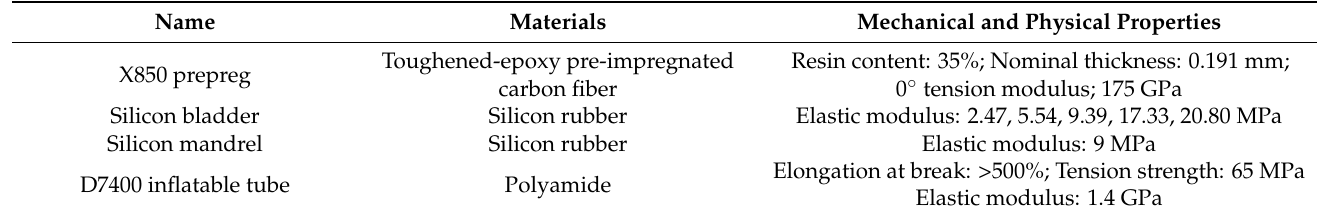
Table 1. Materials used in the experiment.